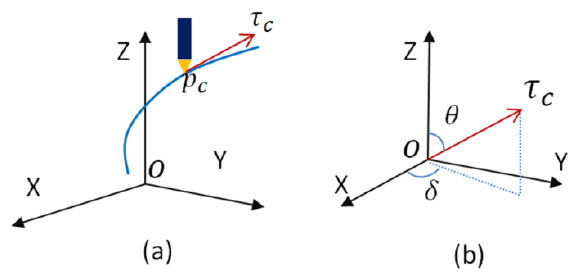
Figure 8. Diagram of the magnitude of the A - and C -axes: ( a ) current printing point; ( b ) the formation of the rotation angle.